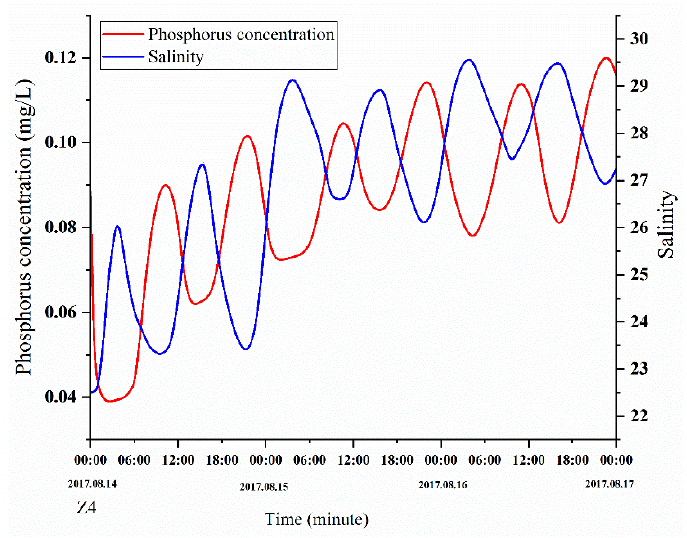
Figure 13. Temporal distribution of phosphorus concentrations and salinity at station 4 during the three days.